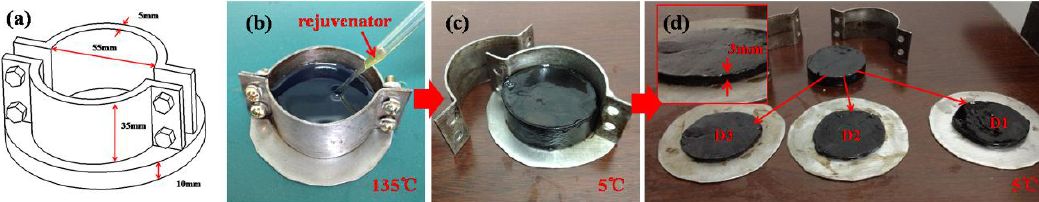
Figure 3. Preparation process of the specimens for dispersal behavior analysis: ( a ) appearance and dimension parameter of the container for aged asphalt binder; ( b ) the asphalt sample at the initial stage of dispersion process; ( c ) the asphalt sample that complete the dispersion process; ( d ) the slices samples which cut at 5 ℃.